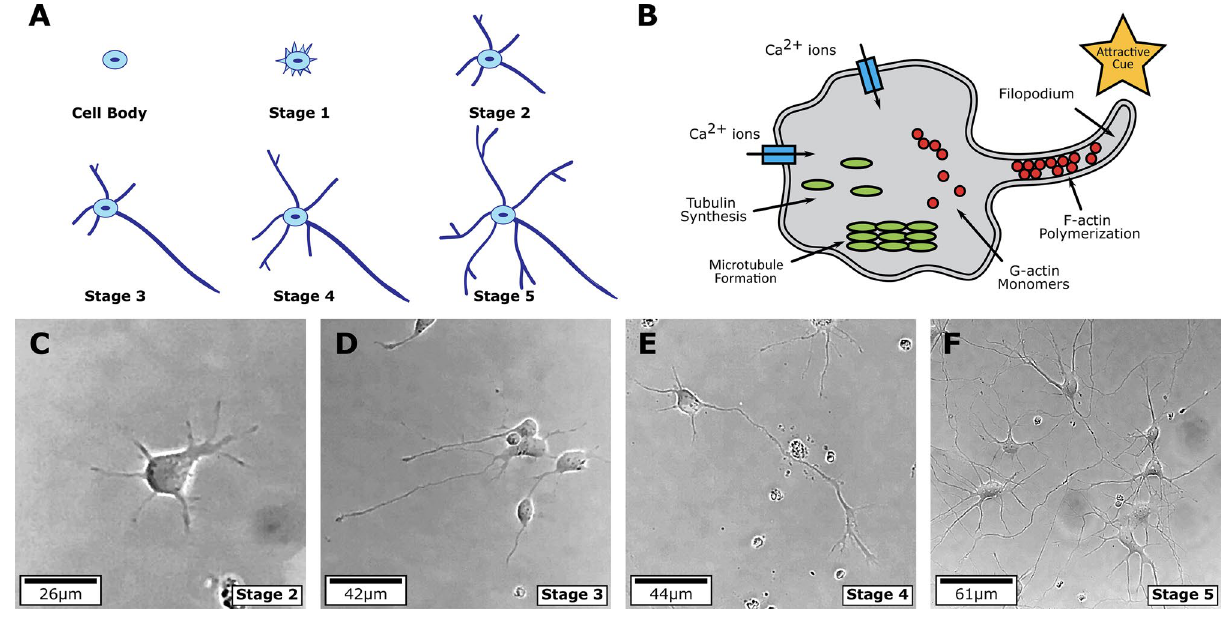
Figure 1. Five stages of neuron growth from initiation to maturation and adapted schematic diagram 15,16 showing the neurite elongation (stages 2–5) in the presence of attractive cues. ( A ) The stages observed are lamellipodia formation (few hours), initial outgrowth of neurites ( ≈ 1 day), axon differentiation ( ≈ 1.5 days), dendrite formation ( ≈ 4 days) and neuron maturation ( (cid:31) 7 days) 1 . ( B ) Tubulin is produced at the cell body